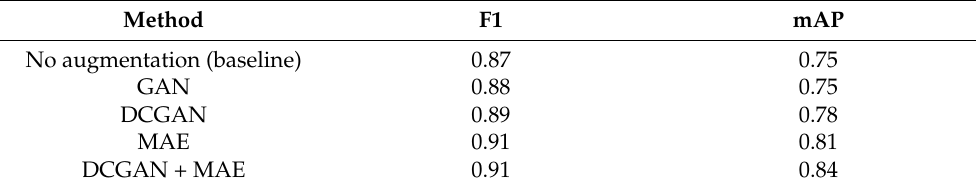
Table 5. Results of different data augmentation